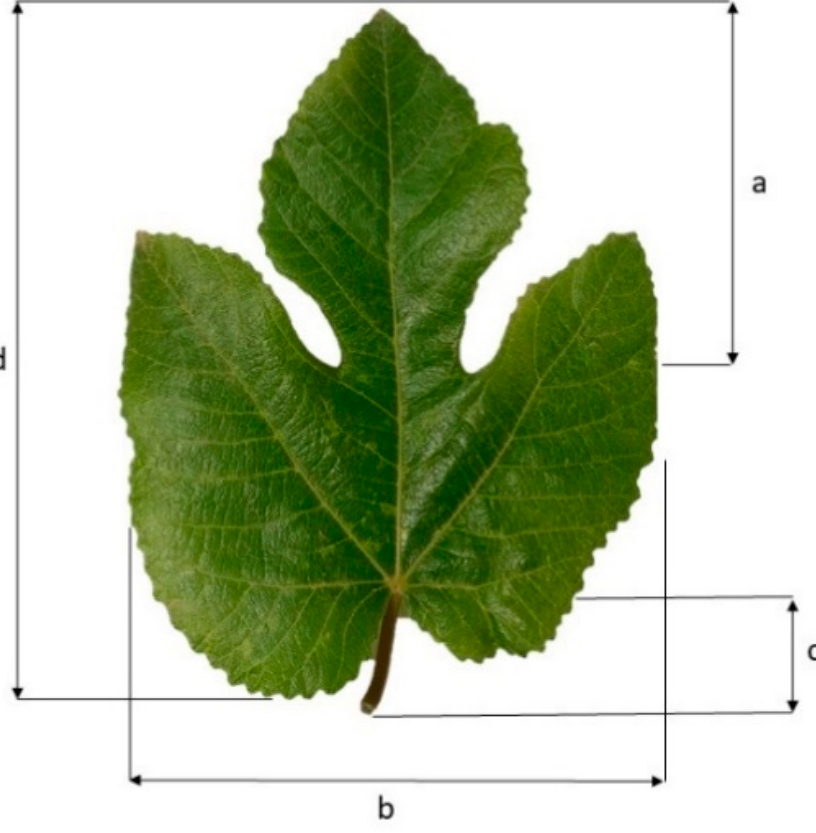
Figure 1. Representation of the measures considered to determine the size of the leaves, where “a” represents length of central lobe (cm); “b” leaf width (cm); “c” petiole length (cm); and “d” leaf length (cm).